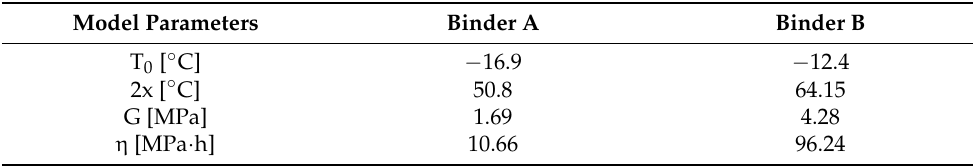
Table 3. One-element model